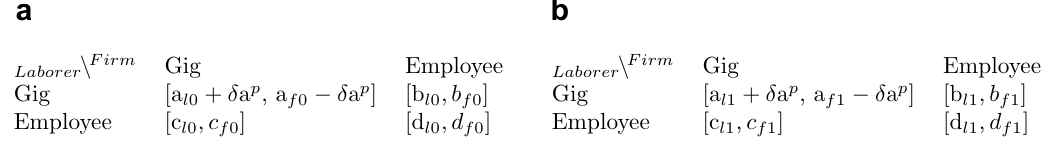
Figure 4: Strict Policy, Matrix Operation Figure 15. Strict policy, matrix operation. ( a ) Strict ordinance, n = 0. ( b ) Strict ordinance, n =